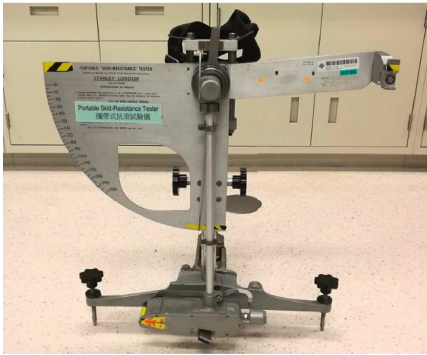
Figure 2: British pendulum